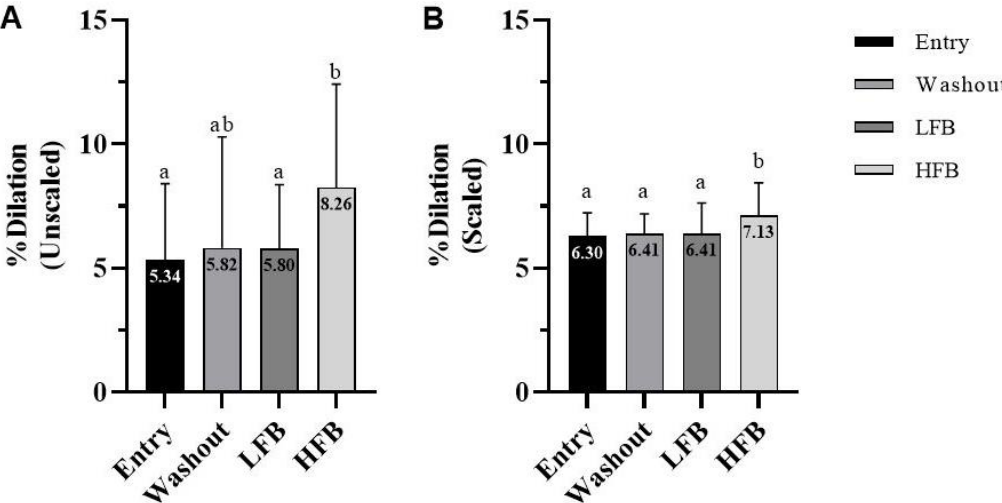
Figure 1. ( A ) Gated flow-mediated dilation. ( B ) Allometrically scaled flow-mediated dilation. Values are percent dilation for entry, washout, LFB intervention, and HFB intervention. Cross-over design ( n = 23); values represent mean ± SD. Means without a common letter differ, p < 0.05.